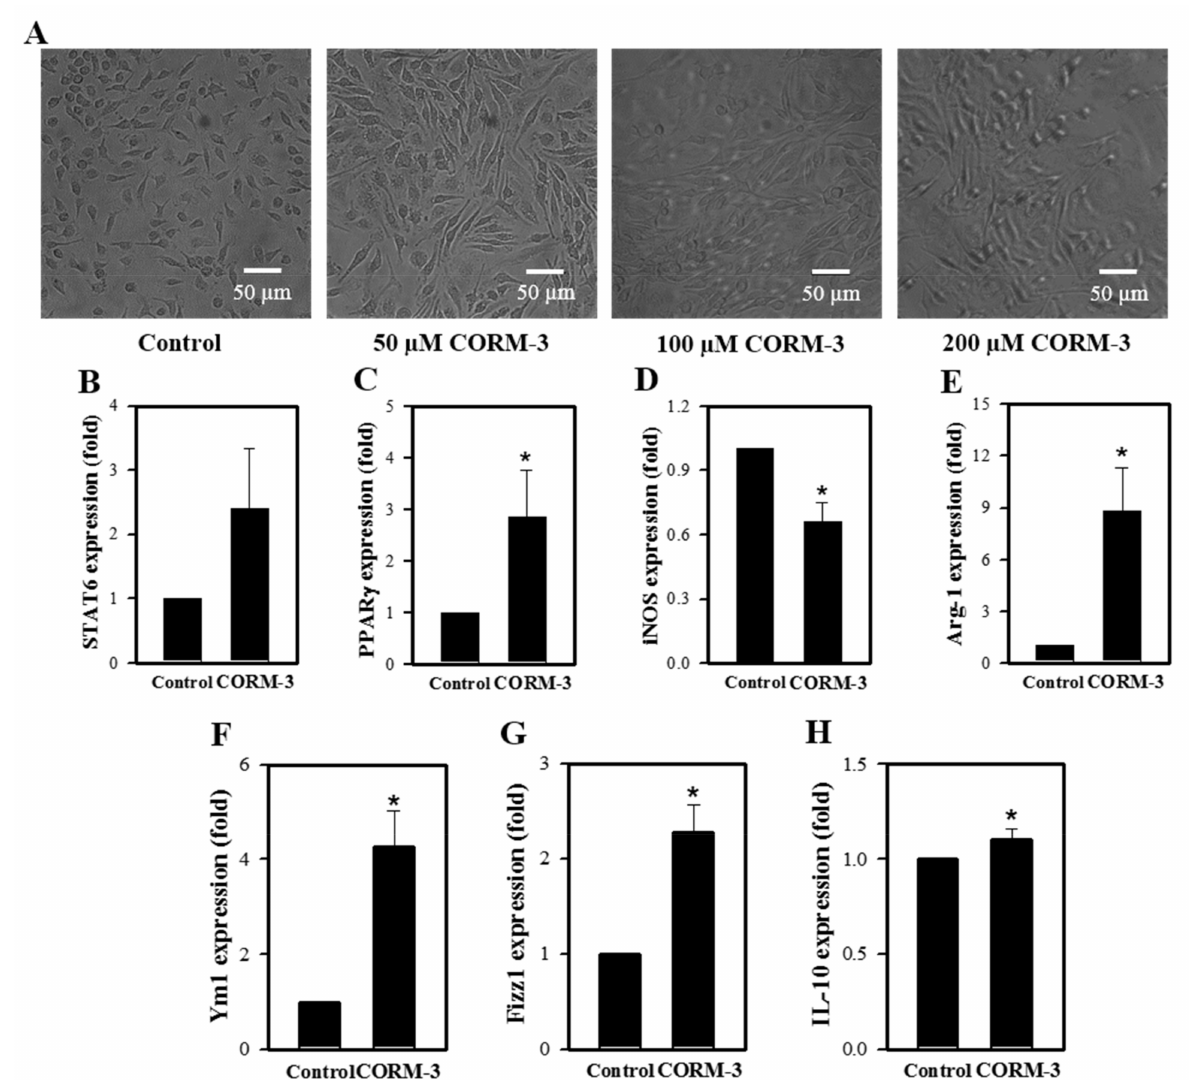
Figure 2. CORM-3 increases genes and molecules involved in M2 polarization but decreases iNOS expression. Murine BMCs were treated with CORM-3 on day 5 in the presence of 30 ng/mL M-CSF and incubated for 5 days to induce macrophage differentiation. ( A ) Representative pictures of cells treated with 0–200 µ M CORM-3 (n = 3). ( B – H ) The mRNA expression levels of STAT6, PPAR γ , iNOS, Arg-1, Ym1, Fizz1, and IL-10 were determined by qRT-PCR (n = 3). GAPDH was used as an internal reference. Results are presented as mean ± SD, * p < 0.05 compared to control (Student’s t